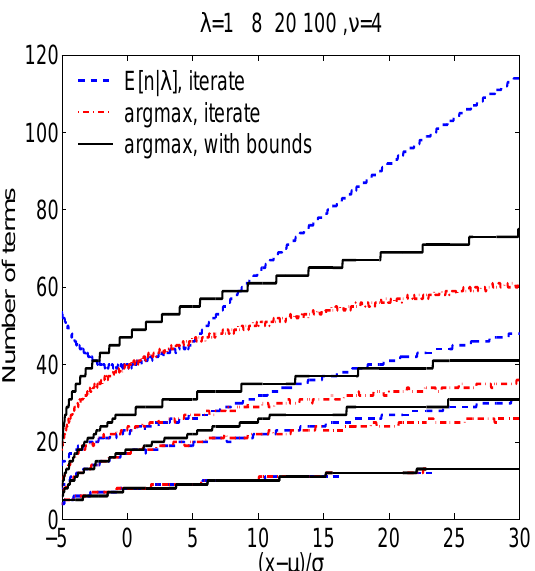
Figure 4. The number of terms necessary for the three algorithms to attain the accuracy shown in Figure 3 for ν = 4 and for various λ of 1, 8, 20 and 100. Algorithm 1, blue dashed. Algorithm 2, red dashed. Algorithm 3, black